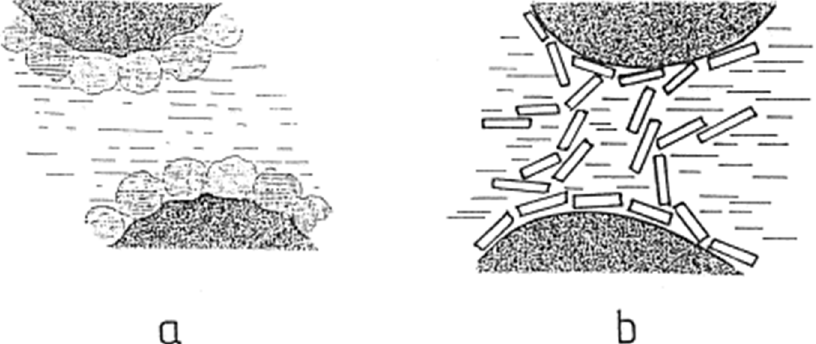
Figure 7. Stabilization mechanisms of the Pickering emulsion. ( a ) Stabilized by envelopes of particles around the oil droplets; ( b ) stabilized by encapsulation of oil droplets in a three-dimensional network of particles [85].